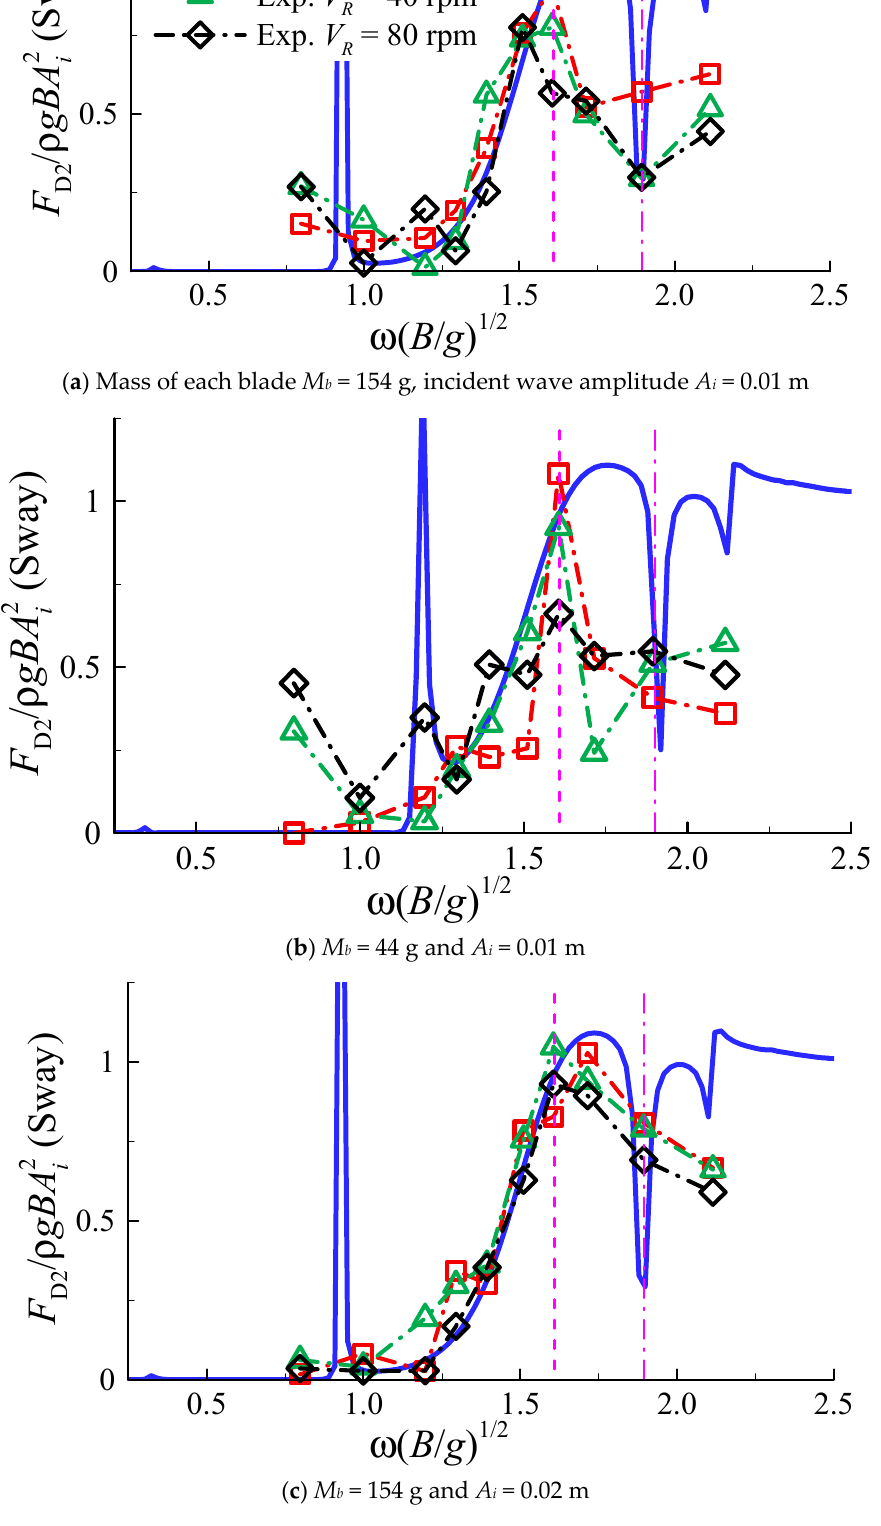
Figure 7. Measured and calculated mean sway drift forces on the floating wind turbine with four moonpools in beam waves ( V R is the rotating speed of wind